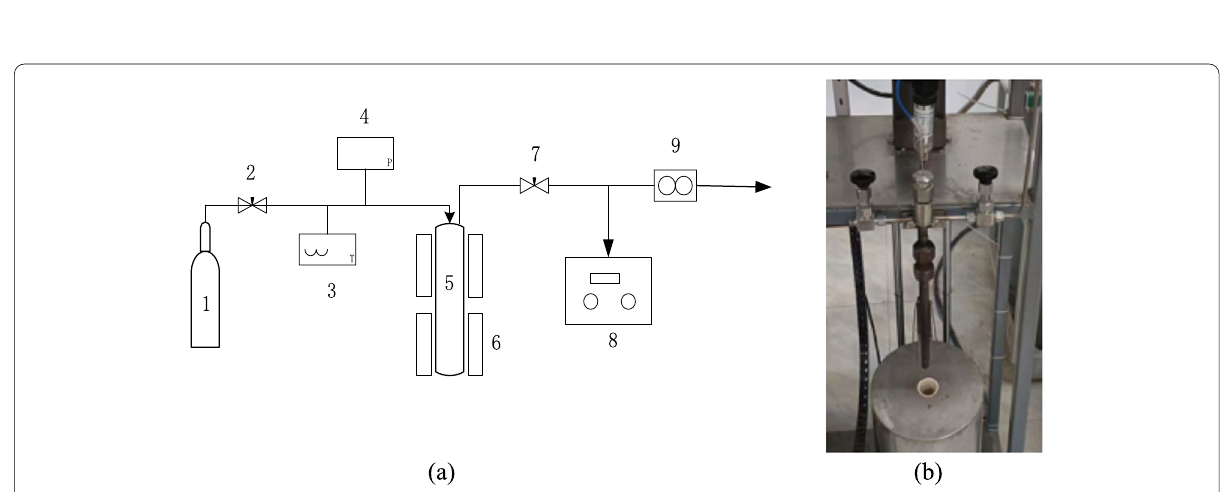
Fig. 1 Schematic diagram of biomass gasification system ( a ) and physical view of autoclave ( b ). 1—gas cylinder, 2—needle valve, 3—temperature controller, 4—pressure sensor, 5—autoclave, 6—electric heater, 7—needle valve, 8—gas chromatograph, 9—gas flow